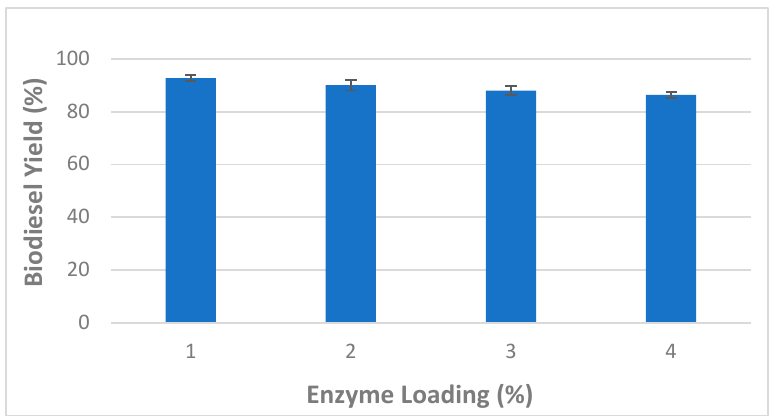
Figure 2. Effect of mixed CaCO 3 -immobilized lipases loading on the transesterification process of waste cooking oil (WCO) for biodiesel synthesis. Experimental conditions were: methanol/oil molar ratio: 6:1, reaction temperature: 45 °C, reaction time 24 h, water content 5%, agitation speed 150 rpm. Experiments were performed in triplicate and error bars indicate mean ± standard deviation.